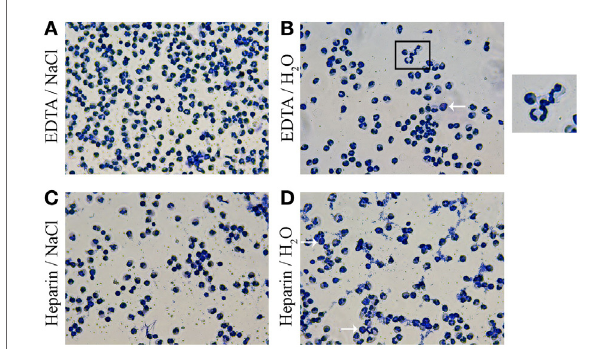
FIGUrE 2 | Morphology of harvested cells with HAEMA fast stain. Harvested cells were centrifuged on cover slips and stained with HAEMA fast stain (DIFF Quick). Samples were analyzed by light-microscopy. Representative pictures are shown. Independent of the anticoagulants and red blood cells (RBCs) lysis the granulocyte population after EDTA/NaCl (A) and lithium heparin/NaCl (c) isolation are presented mainly consist of polymorphnuclear granulocytes (neutrophils). Arrows indicate eosinophils with different (dark reddish) granule staining. More clotting of the granulocytes are detected in samples after lithium heparin/H 2 O isolation (D) . A zoom of the morphology of granulocyte segmented nucleus is shown in (B) and demonstrates the high variability of nucleus